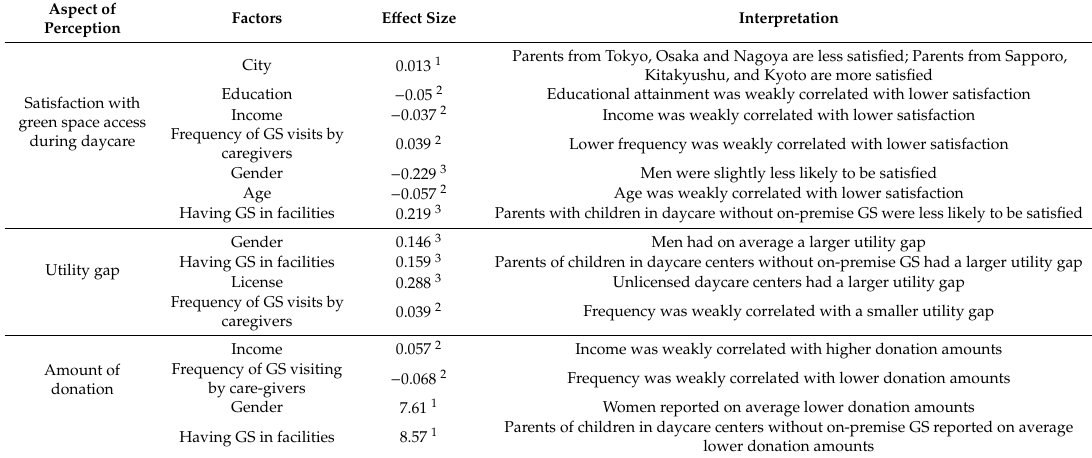
Table 8. Significant e ff ects of factors influencing parents’ perception of and amount willing to pay for green space access ( p <